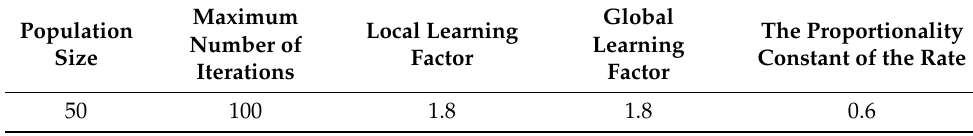
Figure 6. Comparison of the predicted and actual values of the WOA-XGBoost model (population size of 100). Table 4. The initial parameters of the PSO algorithm.